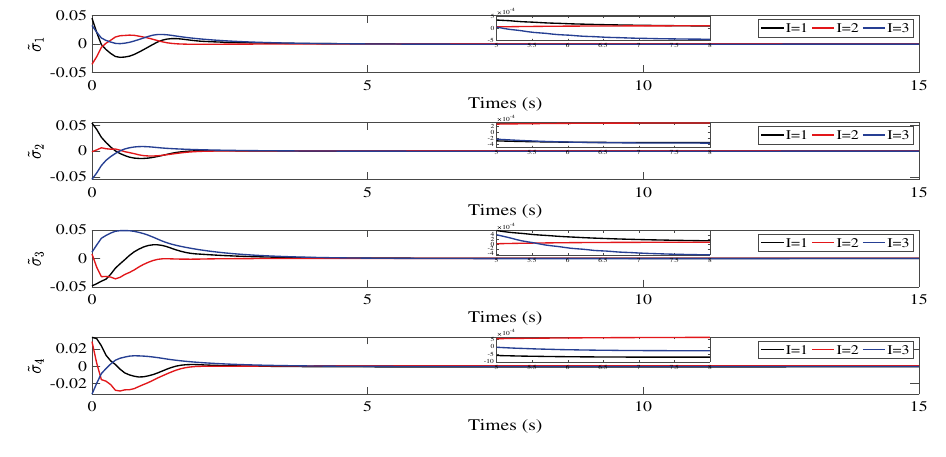
Figure 2. Attitude tracking errors ˜ σ i ( t ) .